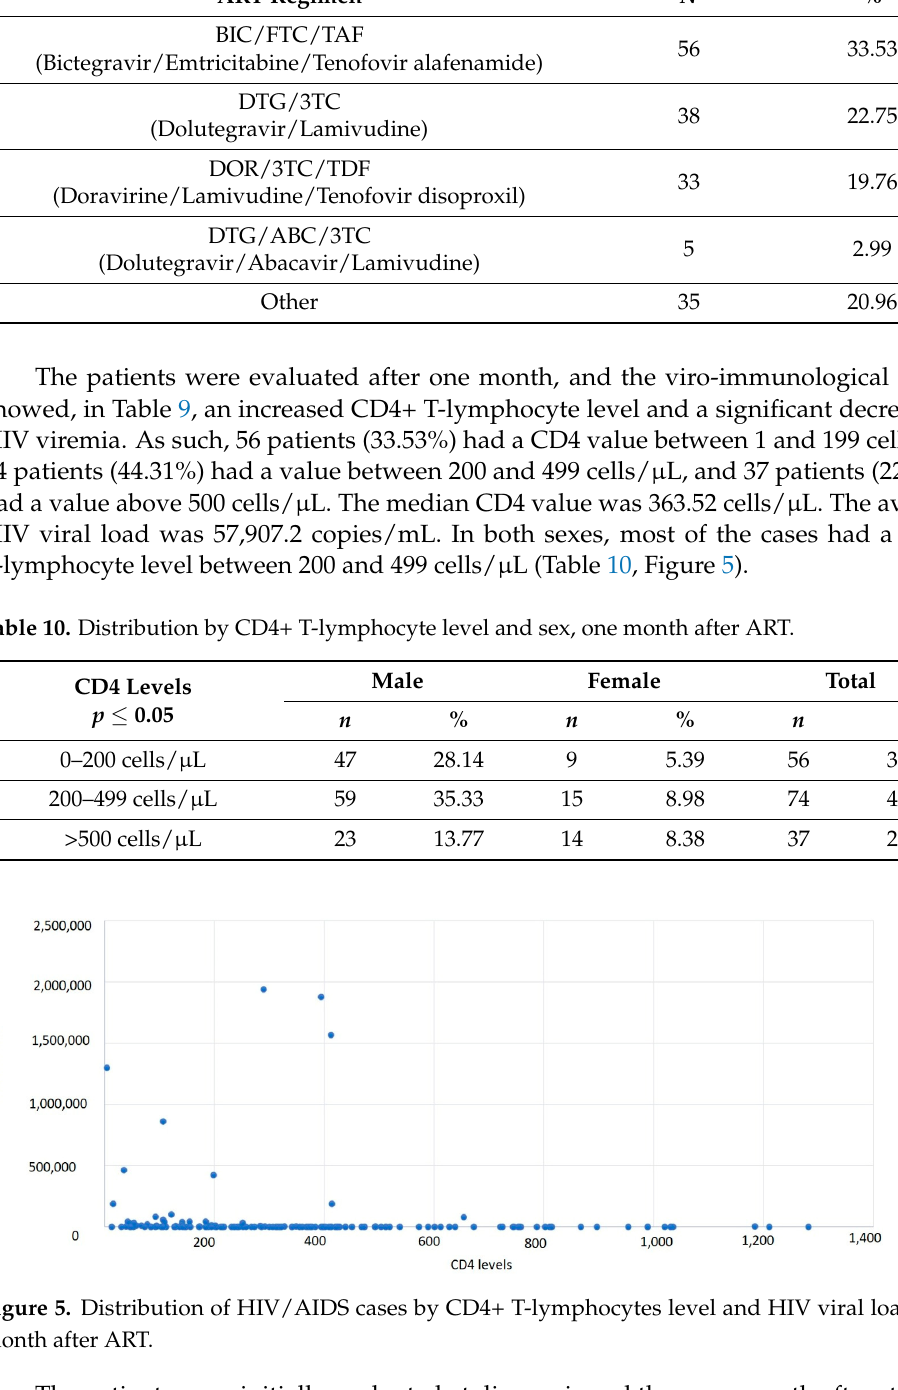
Table 9. Distribution of new HIV/AIDS cases by ART regimen.